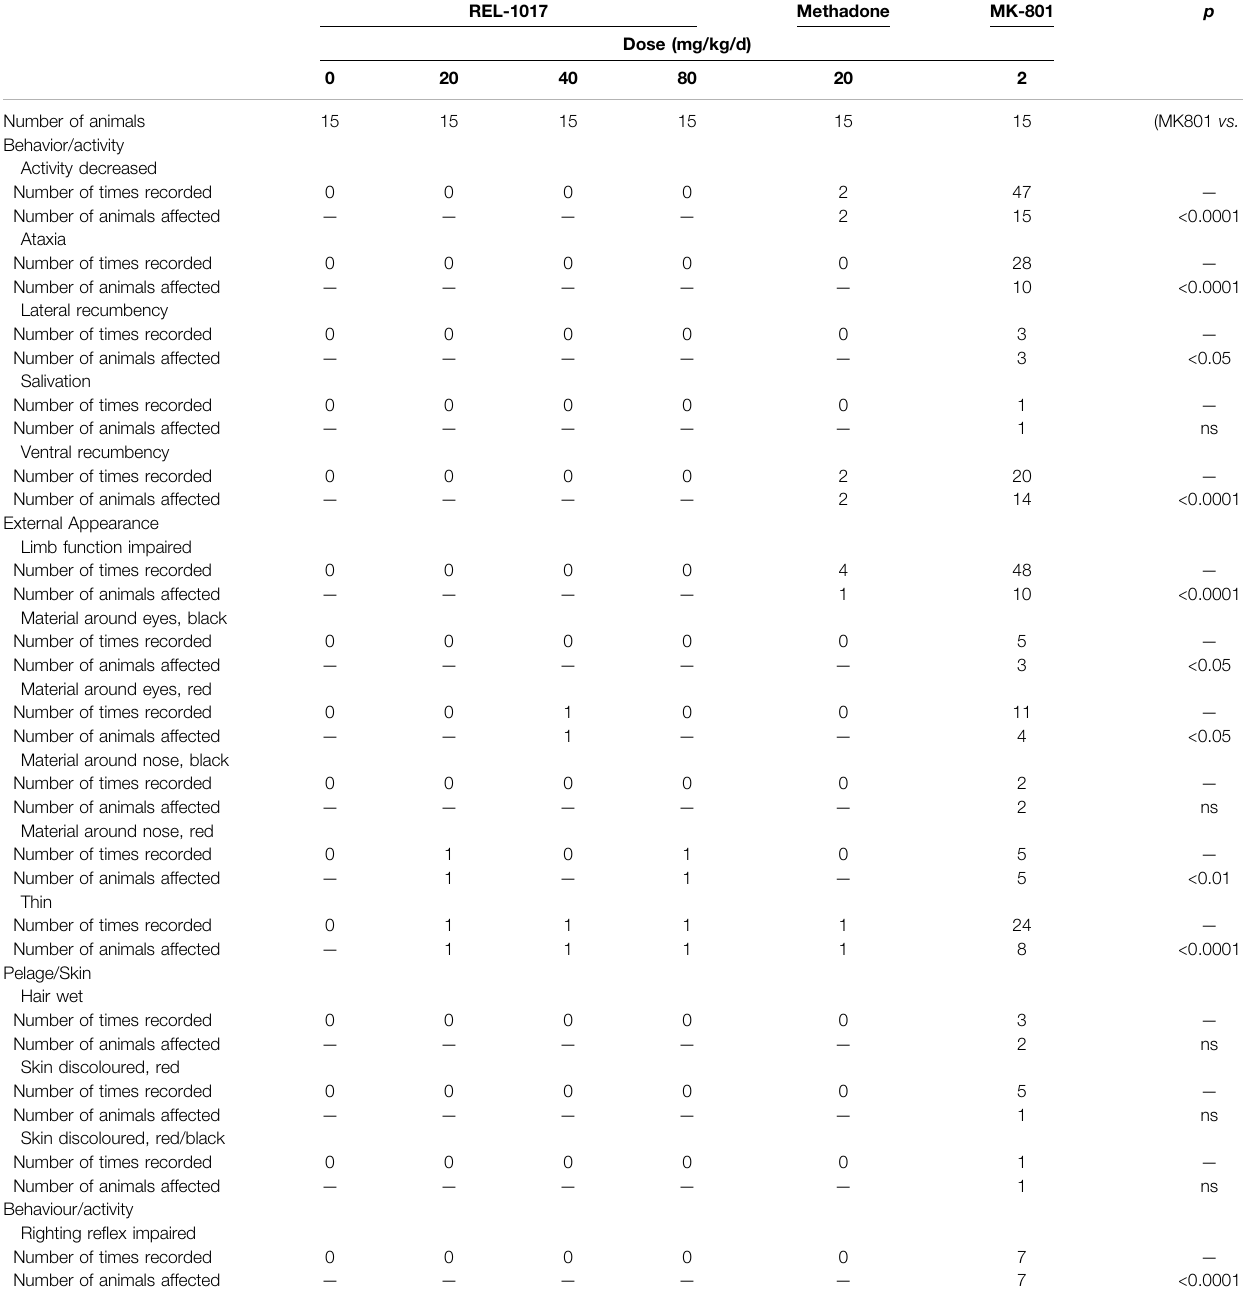
Number of animals affected < 0.0001 Pelage/Skin Hair wet Number of times recorded Number of animals affected ns Skin discoloured, red Number of times recorded Number of animals affected ns Skin discoloured, red/black Number of times recorded Number of animals affected — — ns Behaviour/activity Righting re fl ex impaired Number of times recorded Number of animals